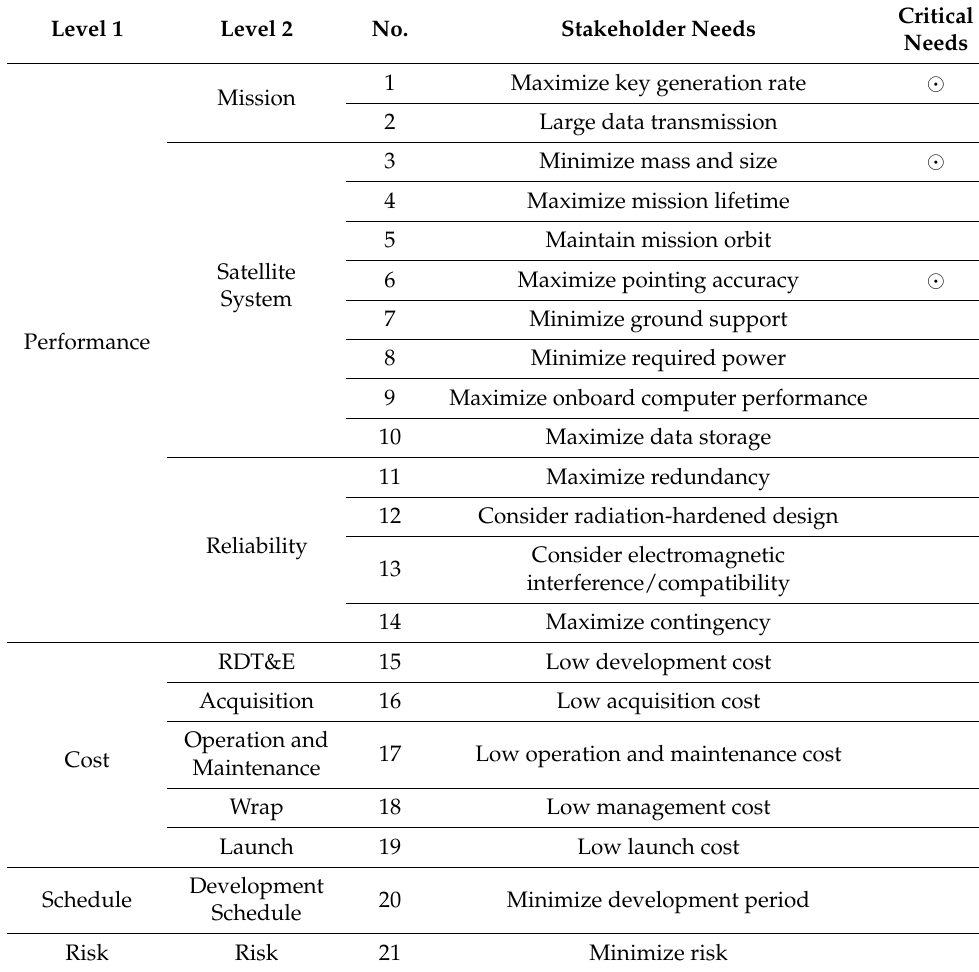
Table 2. Stakeholder needs